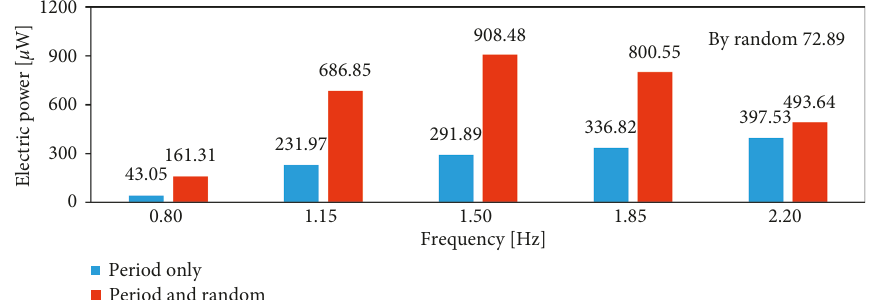
Figure 15: Verification results for the effect of stochastic resonance on power